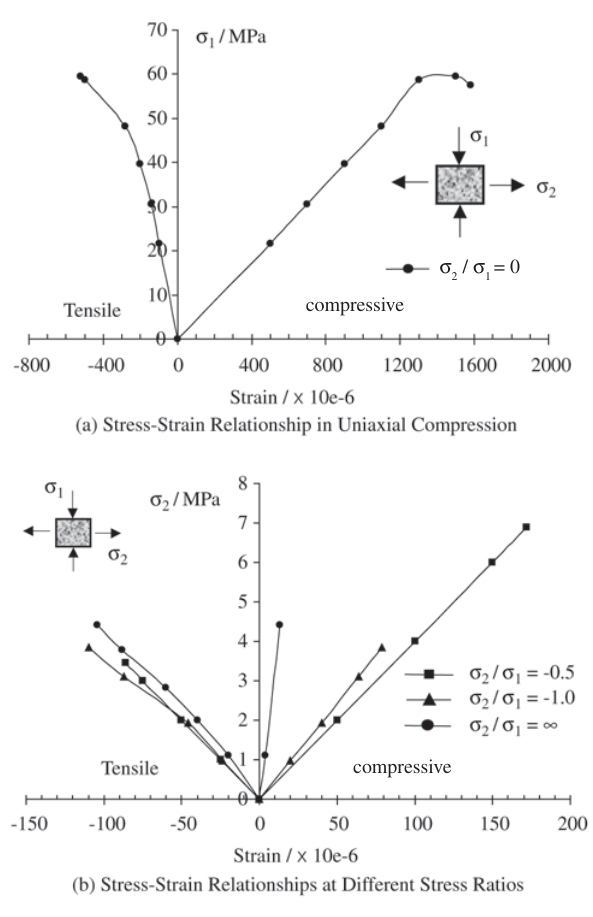
Figure 1. Stress-Strain Relationships at Different Stress Ratios.